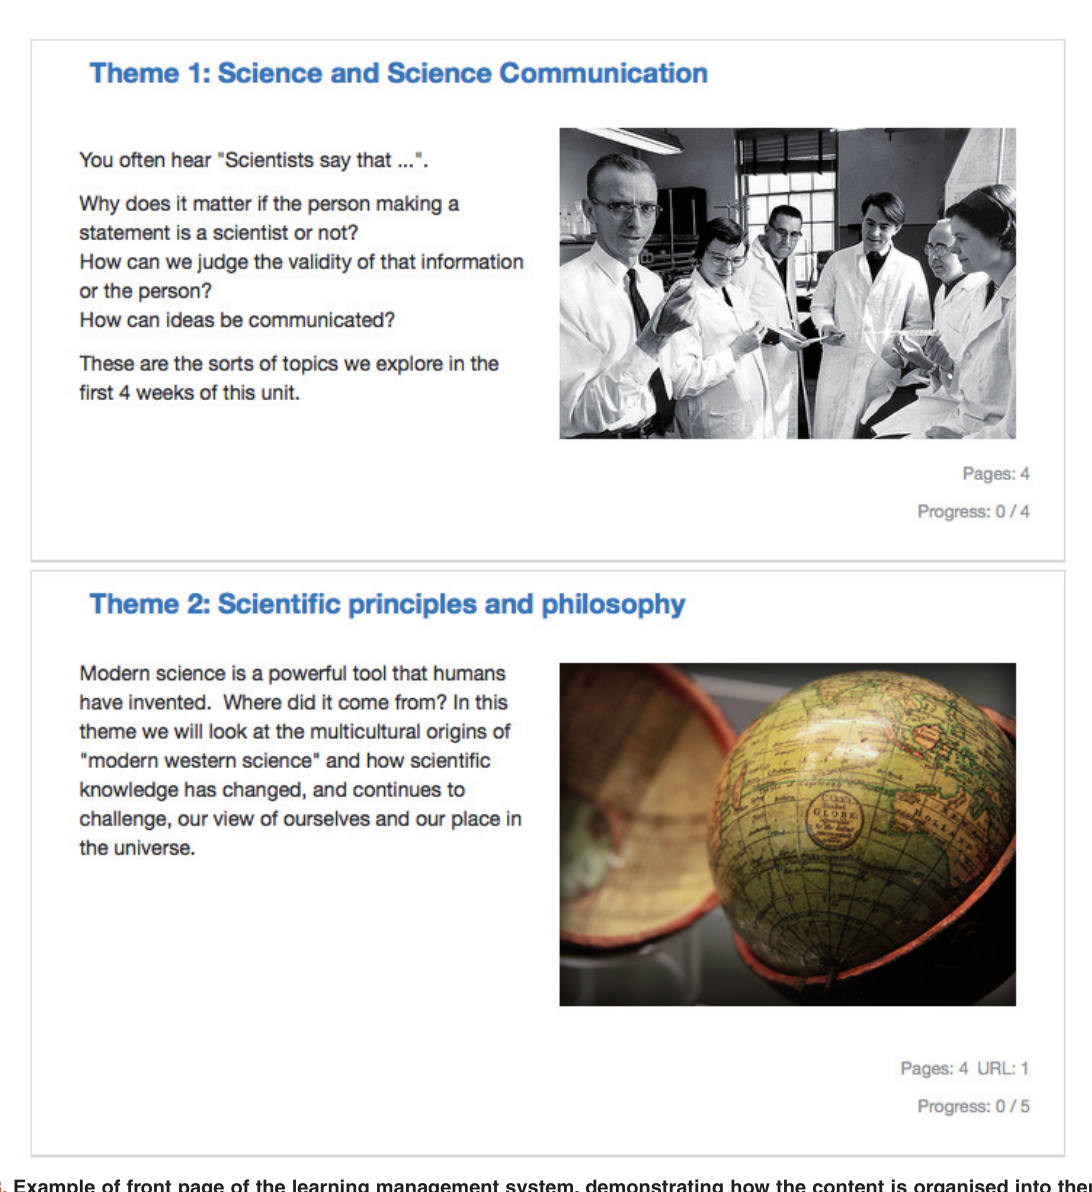
Figure 3. Example of front page of the learning management system, demonstrating how the content is organised into themes with arresting images. Pictures from Creative Commons. Image of scientists: Mars-discovery-district; Image of globe: